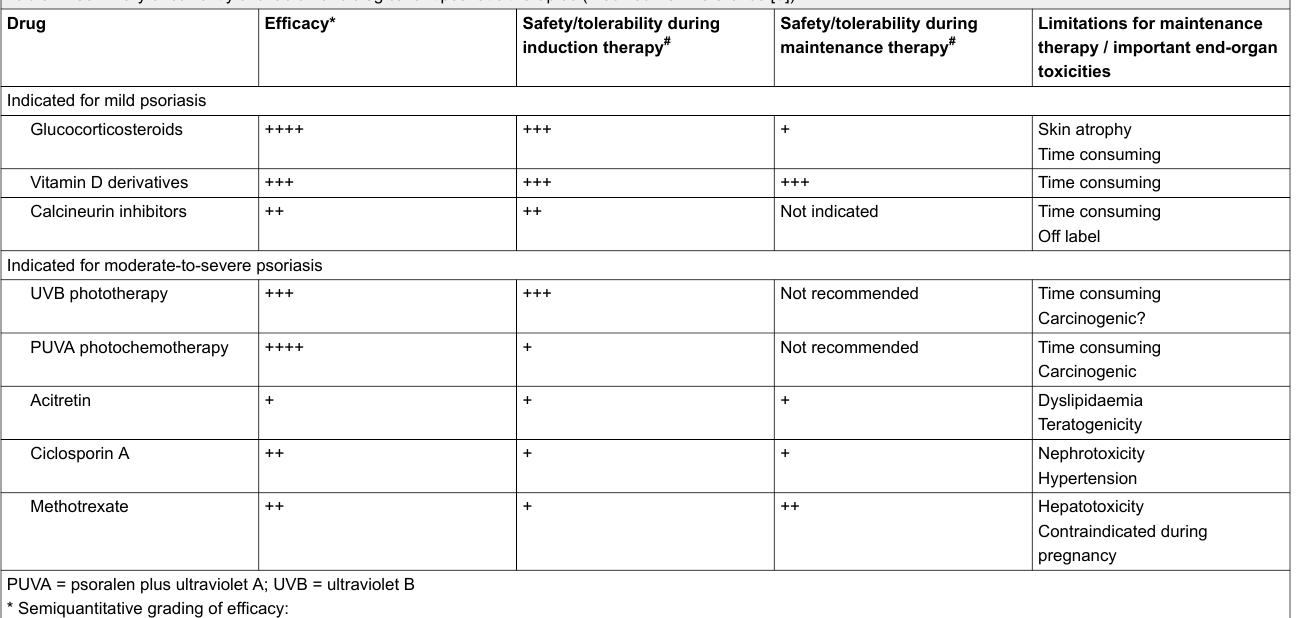
Safety/tolerability during Limitations for maintenance induction therapy # maintenance therapy # therapy / important end-organ